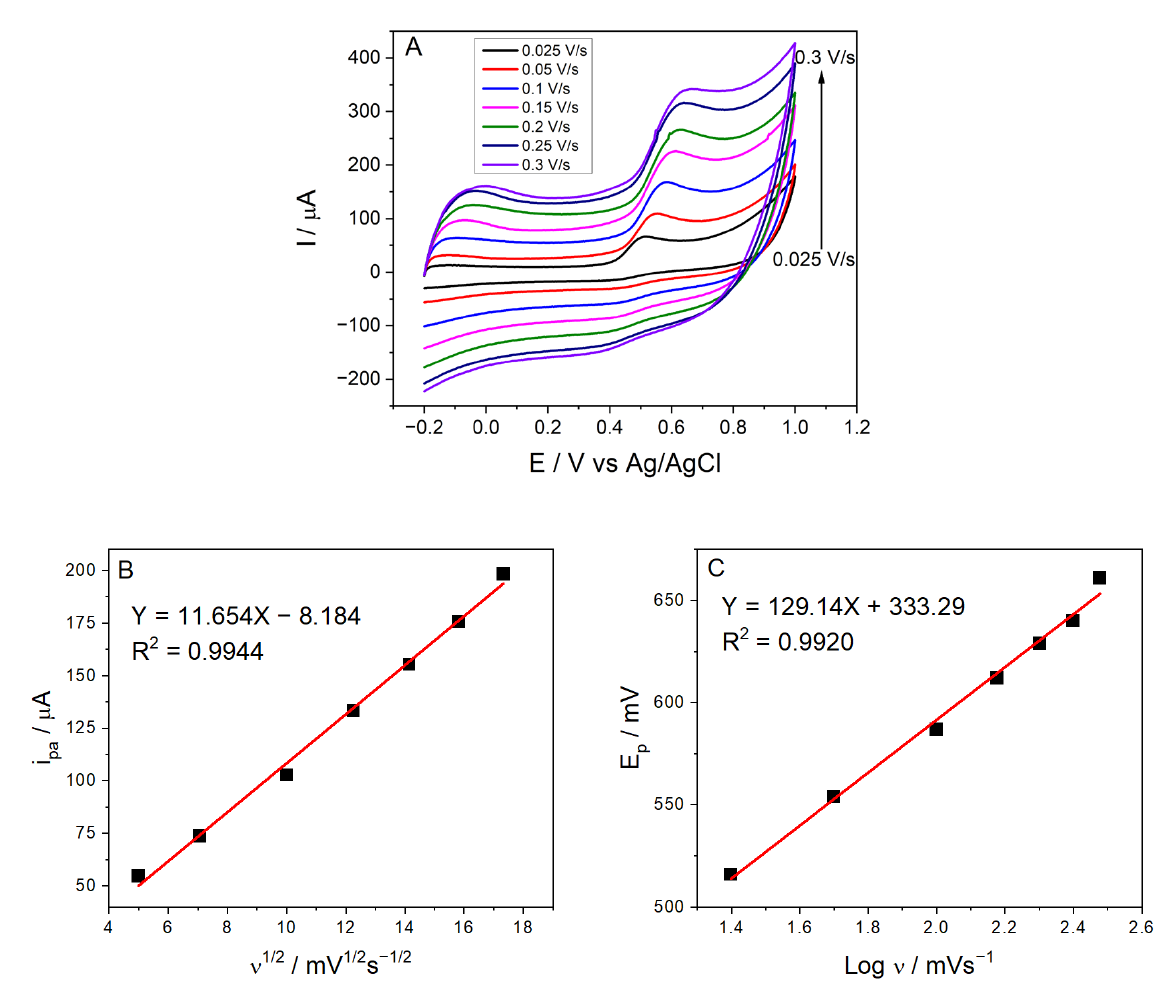
Figure 6. ( A ) Cyclic voltammograms performed with MWCNT-CS/SPE at different scan rates (acetate buffer 0.1 M, pH 5, 1 mM nitrite, scan rate 0.025: 0.05; 0.1;0.15; 0.2; 0.25 and 0.3 V/s). ( B ) Plot of anodic peak current (Ipa) vs. square root of the scan rate ( ν 1/2 ). ( C ) Plot of anodic potential (Epa) vs. log of the scan rate (log ν).